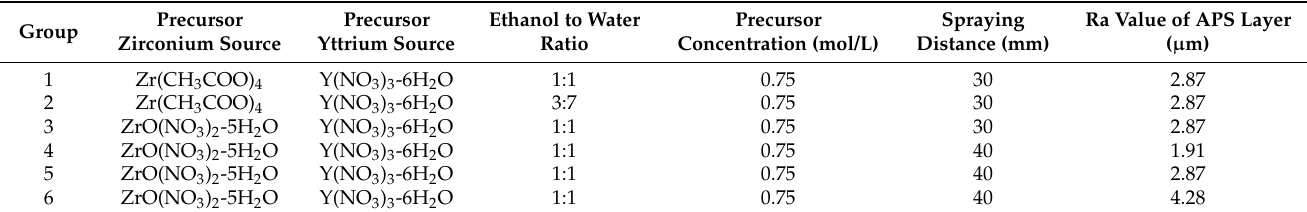
Table 1. Process parameters of SPPS